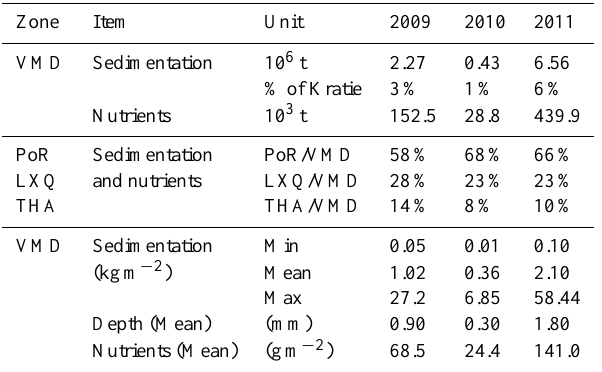
Table 4. Cumulative sediment and nutrient deposition mass in dif- ferent spatial units in VMD floodplains (absolute mass and relative to Kratie), and spatial variability of sedimentation rate, deposition depths and nutrient deposition rates in the VMD.